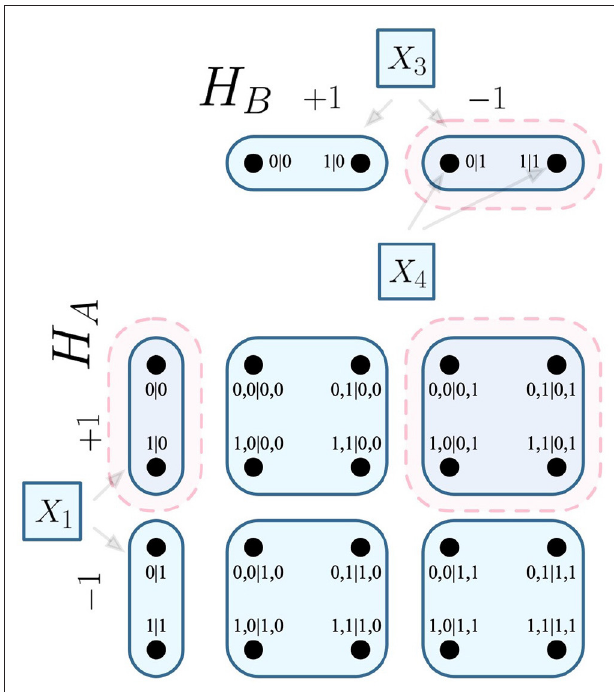
FIGURE 6 | Visualization of relation within Figure 5C , given that X 3 = − 1. The relation produced by the causal influence (and its derivative hyperedges) are highlighted in